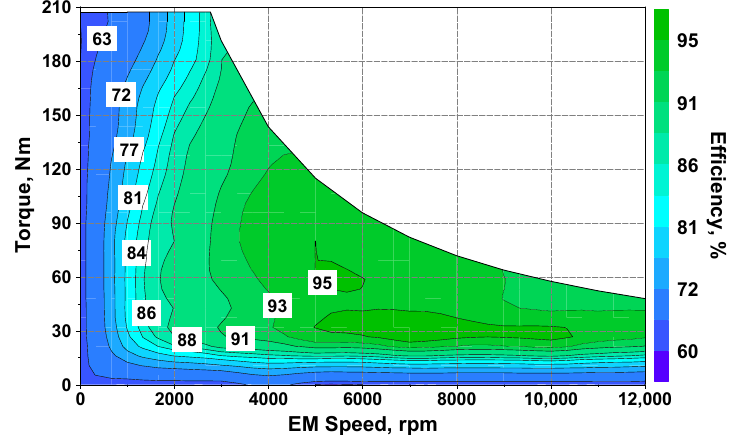
Figure 3. Electric machine efficiency map, %.